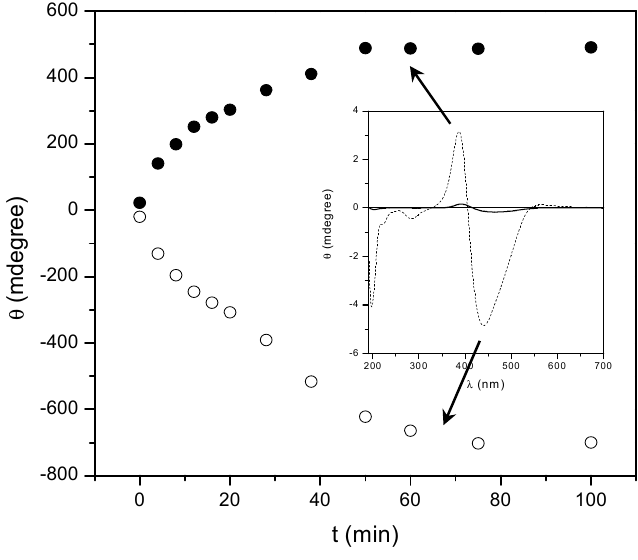
Figure 7. Evolution of the ellipticity at 385 ( ● ) and 450 nm ( ○ ) versus the annealing time relative to poly[( S )- MAP-C ] amorphous thin film heating at 200 °C.